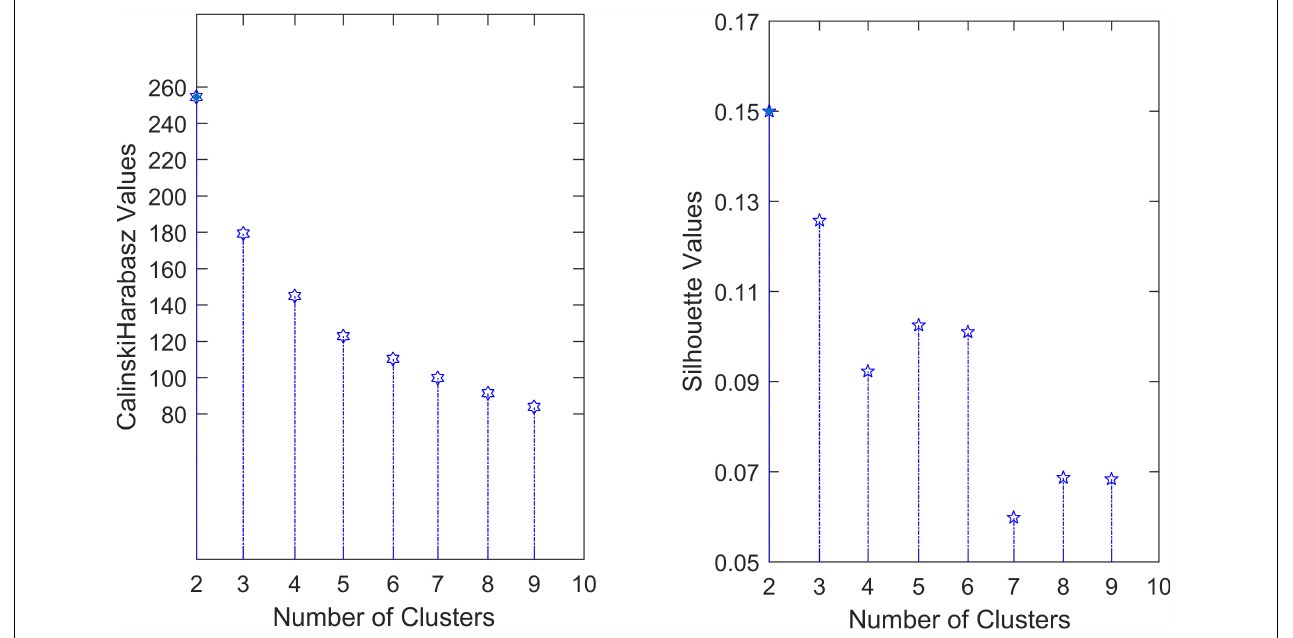
FIGURE 3 | Optimization for the number of